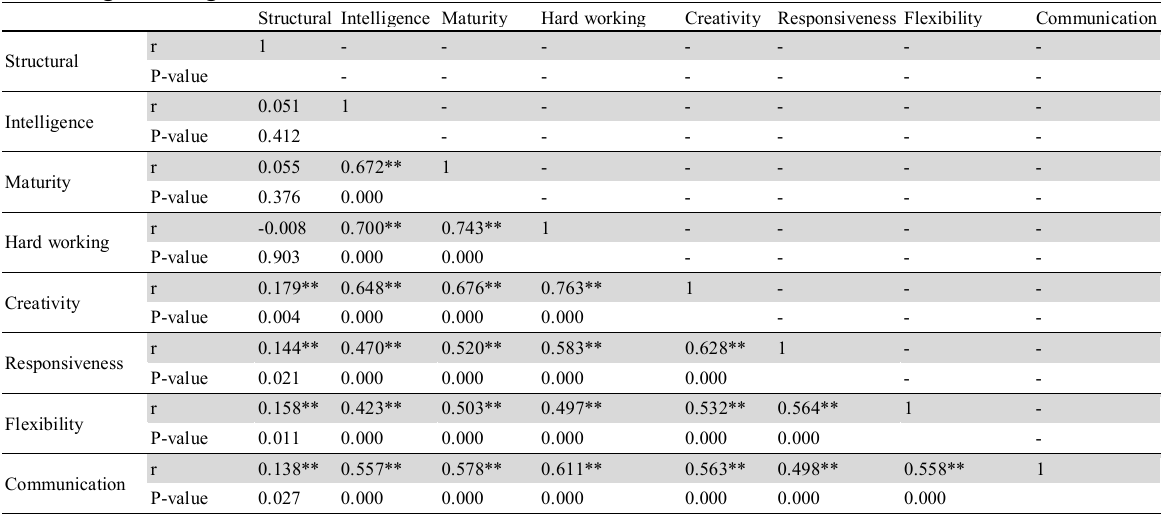
The summary of Pearson correlation test for workforce agility and structural components of knowledge sharing